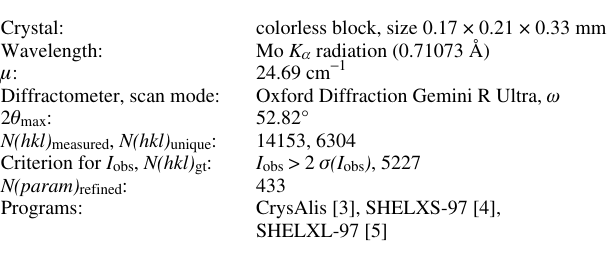
Table 1. Data collection and